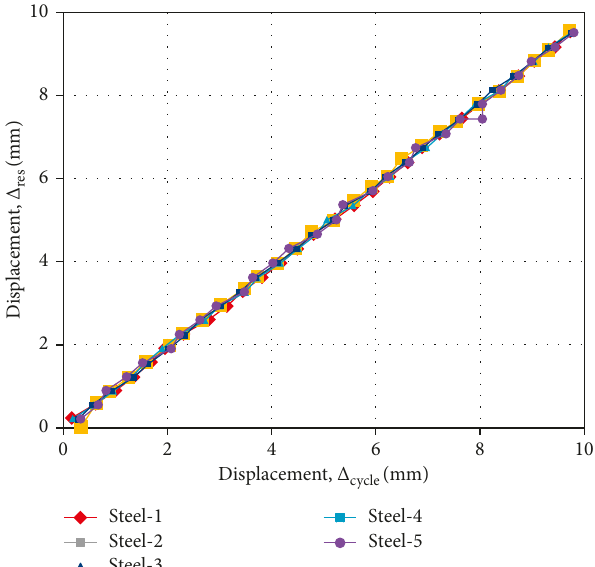
Figure 22: Comparison for residual displacements along the measurement displacement loading cycles (steel material model